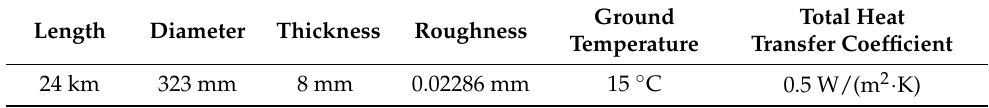
Table 4. Simulation conditions.